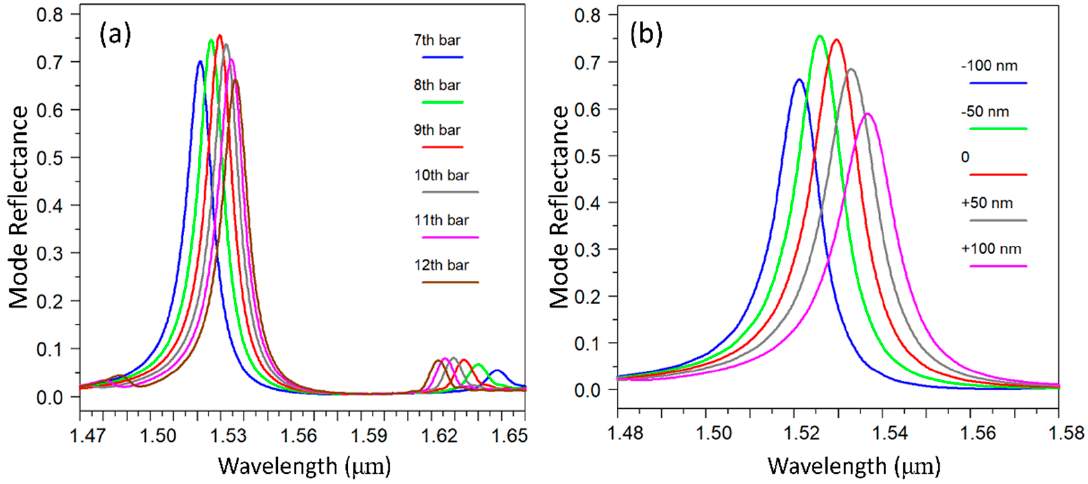
Figure 4. Mode reflectance for the designed RWG ( a ) with Au mirrors located at the center of different grating bars, and ( b ) for different deviations of the mirror planes from the center of the ninth grating bar.